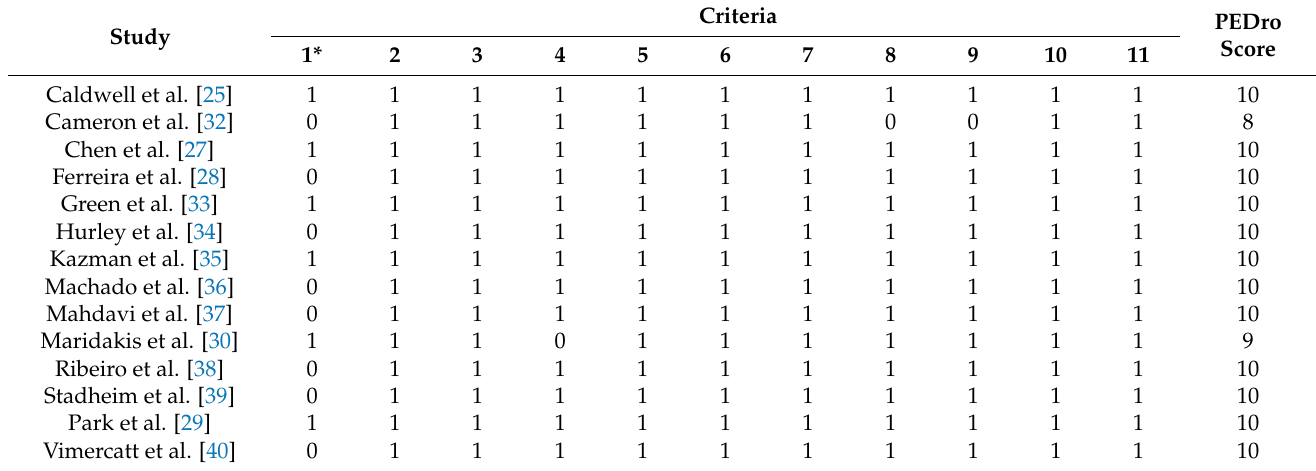
Table 2. Assessment of the methodological quality of studies using the PEDro